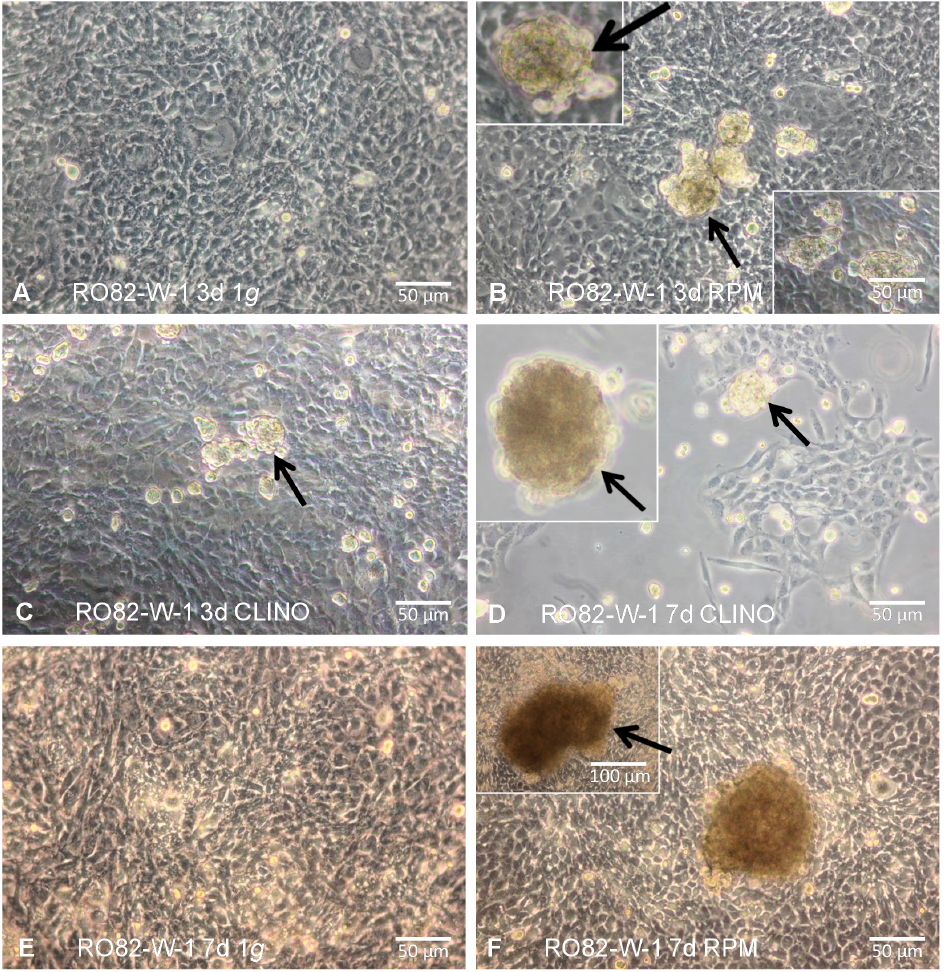
Figure 1. Formation of 3D spheroids: RO82-W-1 cells cultured for 3/7 days at static 1× g results in a